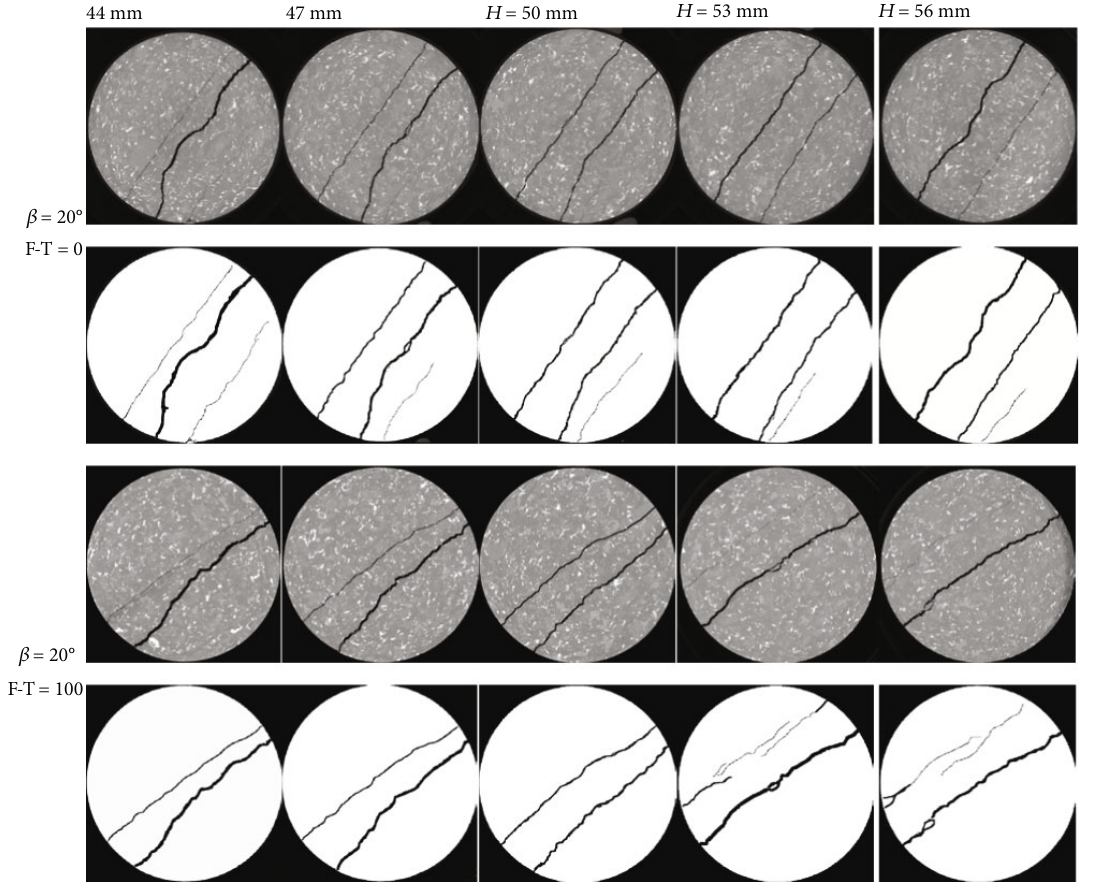
Figure 12: X-ray CT reconstruction images and crack pattern for the sample having an approach angle of 20 ° subjected to 0 and 100